Question: Looking at the figure, what chart type is it?
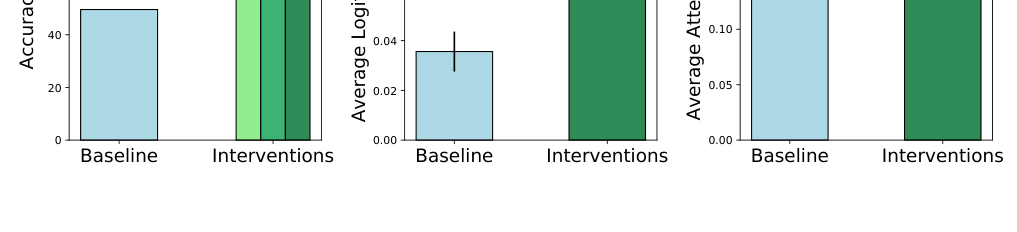
Answer: bar